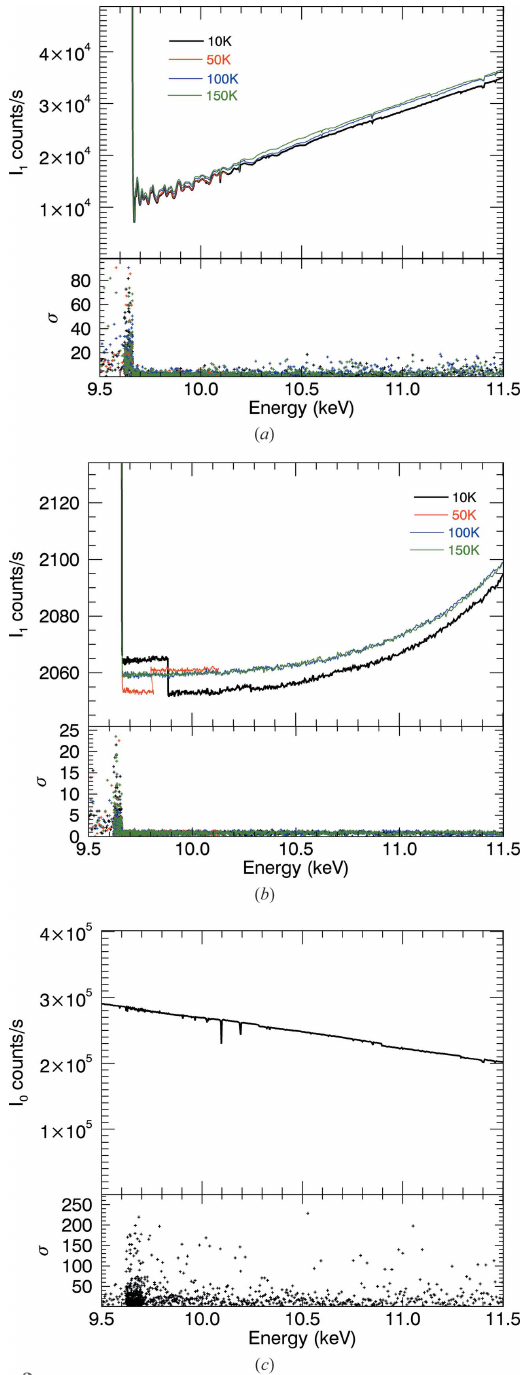
Figure 3 Raw counts and experimental standard errors (cid:4) of three repeated measurements of the upstream and downstream ion chambers. Tempera- tures are given for the ( a ) 10 m m and ( b ) 50 m m foils. The 50 m m foil attenuated excessively towards the dark-current limit. Pre-edge counts read 1.3 (cid:5) 10 5 and 3.5 (cid:5) 10 4 for the 10 m m and 50 m m foils, respectively. ( c ) I 0 is independent of temperature and remained relatively consistent with the exception of Bragg glitches.